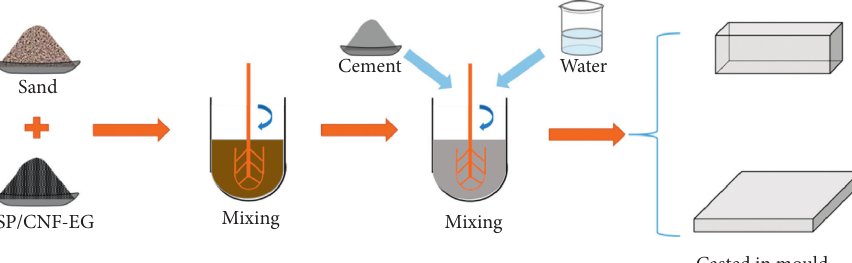
Figure 1: Schematic illustration of fabricating thermal energy storage cement mortar containing DSP/CNF-EG by physical blending.